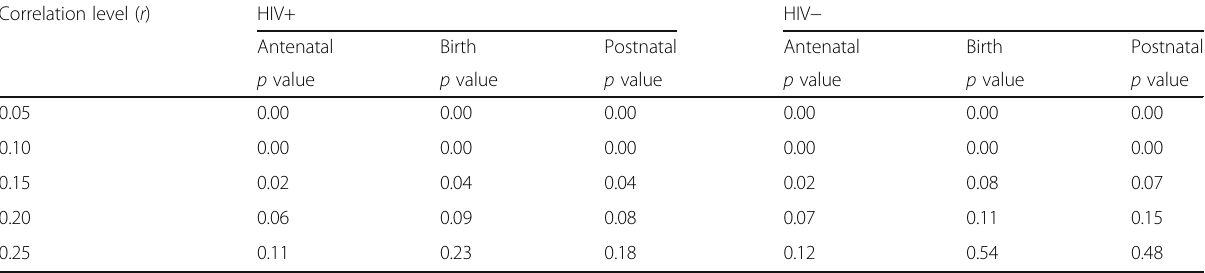
Table 5 Appendix G: Atonji test (under-five mortality). Summary of p values from different r levels